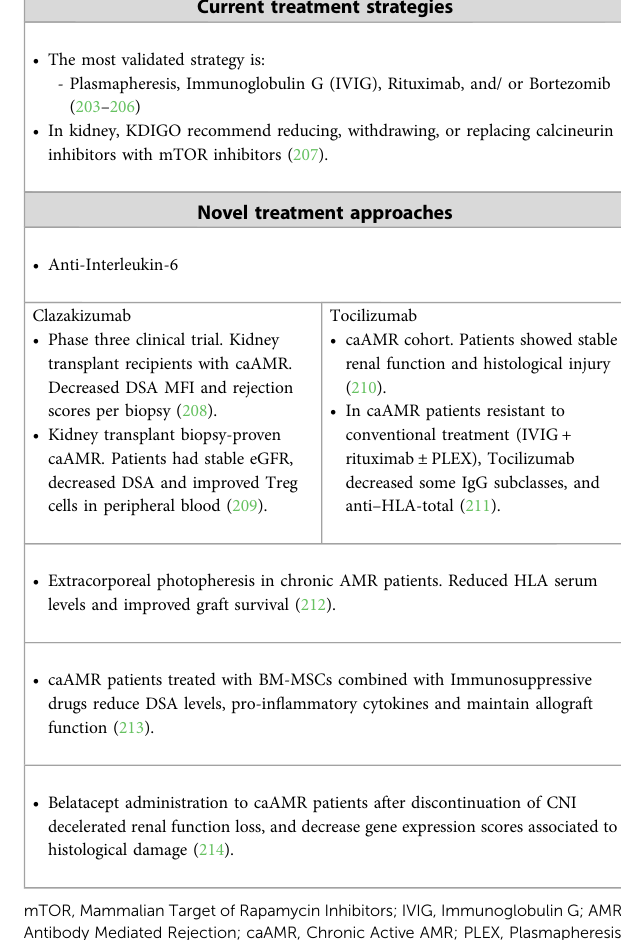
TABLE 2 Current and novels strategies to treat chronic AMR in solid organ transplantation. Current treatment